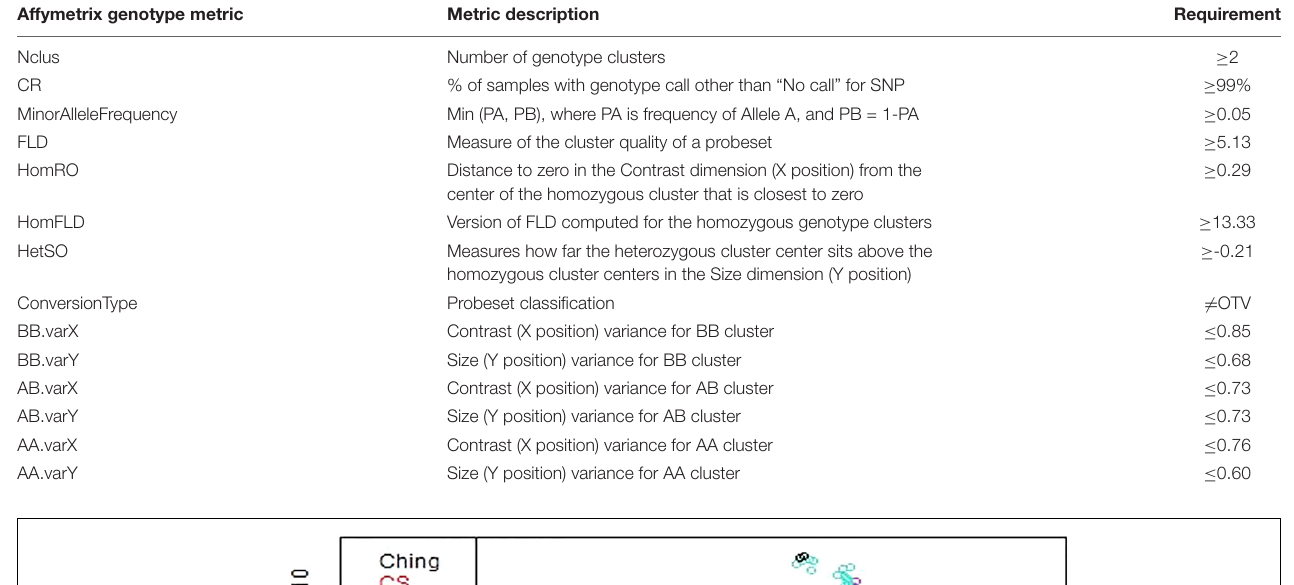
TABLE 1 | Genotype quality metrics provided by Affymetrix and the requirements used in quality control filtering.